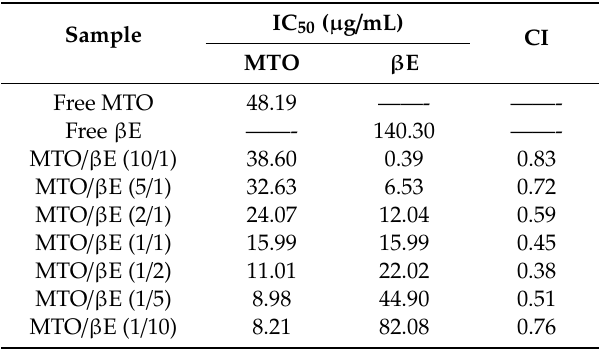
Table 1. The half maximal inhibitory concentration (IC 50 ) and combination index (CI) of various MTO and β E formulations against K562 / DOX cells after 48 h of incubation ( n = 3). IC 50 ( µ g / mL) Sample CI MTO β E Free MTO 48.19 ——- ——- Free β E ——- 140.30 ——- MTO / β E (10 / 1) 38.60 0.39 0.83 MTO / β E (5 / 1) 32.63 6.53 0.72 MTO / β E (2 / 1) 24.07 12.04 0.59 MTO / β E (1 / 1) 15.99 15.99 0.45 MTO / β E (1 / 2) 11.01 22.02 0.38 MTO / β E (1 / 5) 8.98 44.90 0.51 MTO / β E (1 / 10) 8.21 82.08